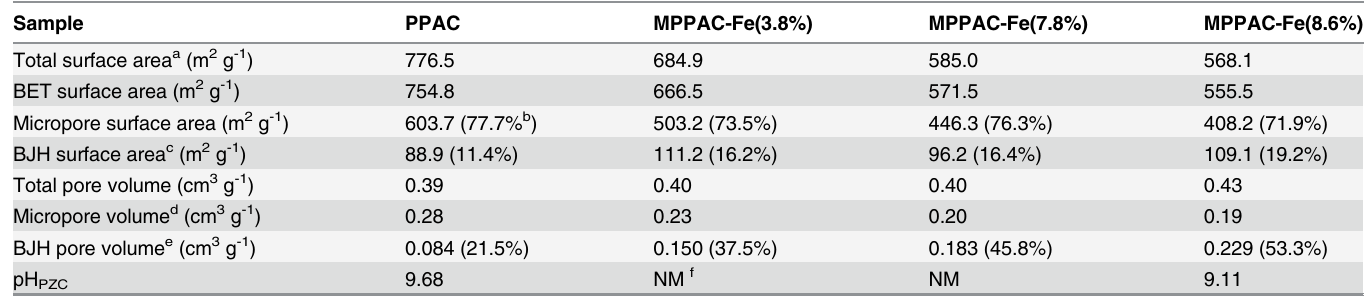
Table 1. Pore characteristics of PPAC and